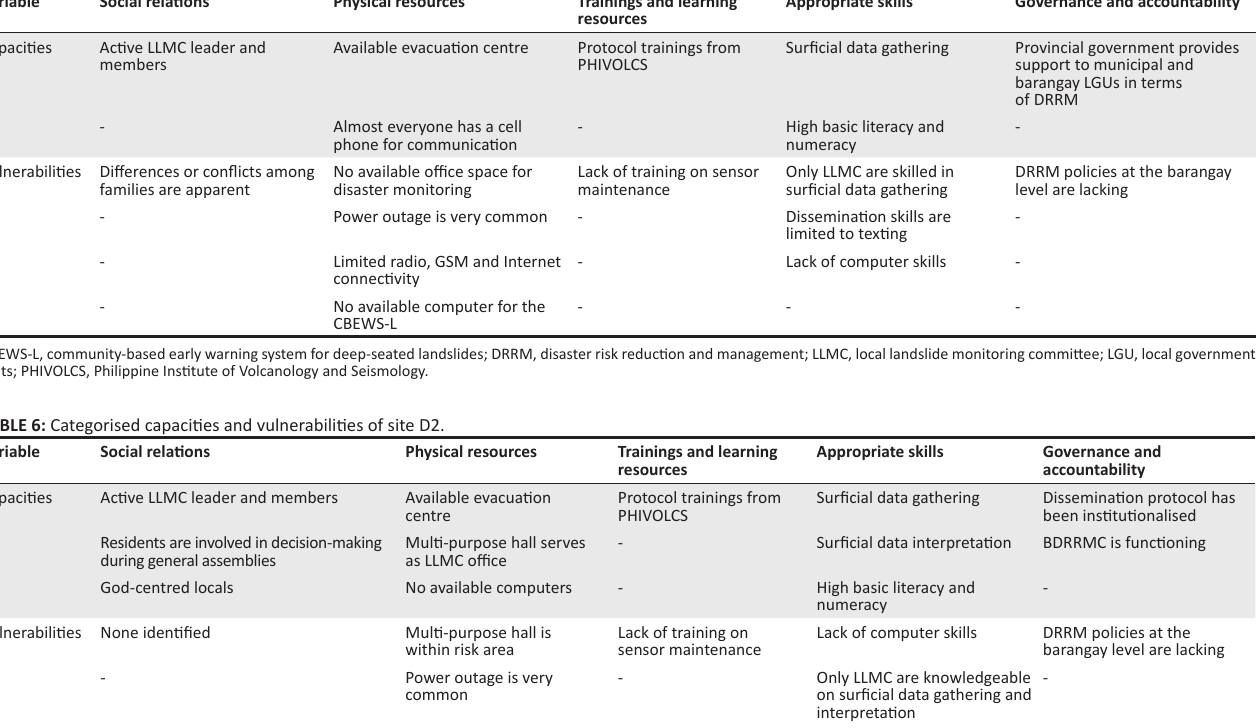
TABLE 5: Categorised capacities and vulnerabilities of site D1.